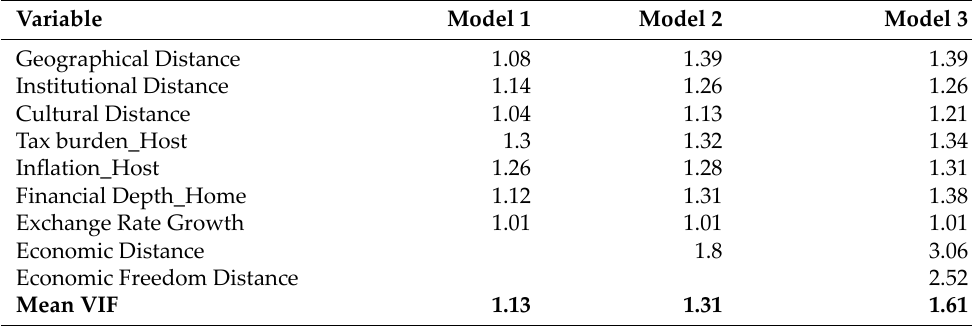
Table 4. VIF values for all the models used in the Tobit